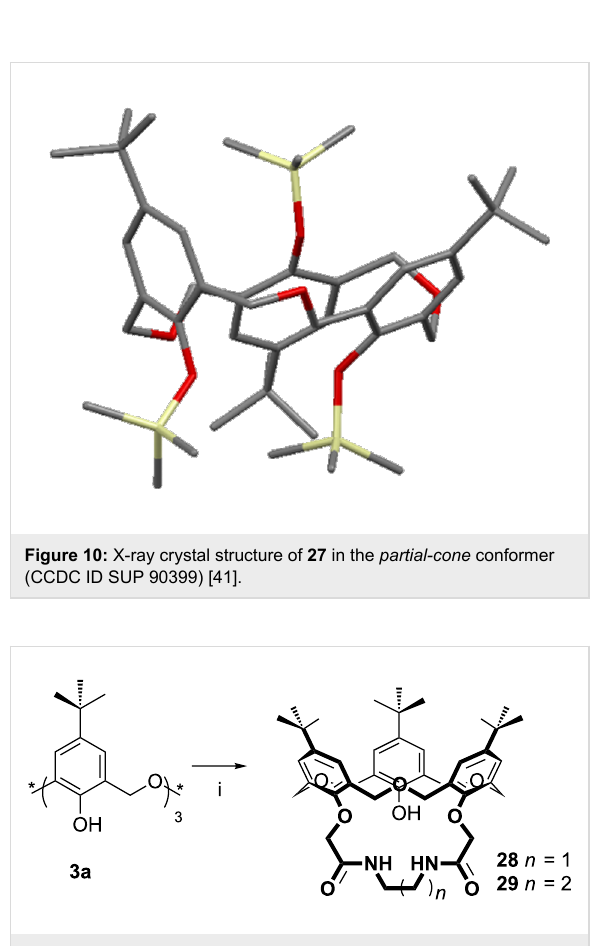
Scheme 16: Synthesis of strapped oxacalix[3]arene derivatives 28 and 29 : (i) N , N ’-Bis(chloroacetyl)-1,2-ethylenediamine or N , N ’-bis(chloro-